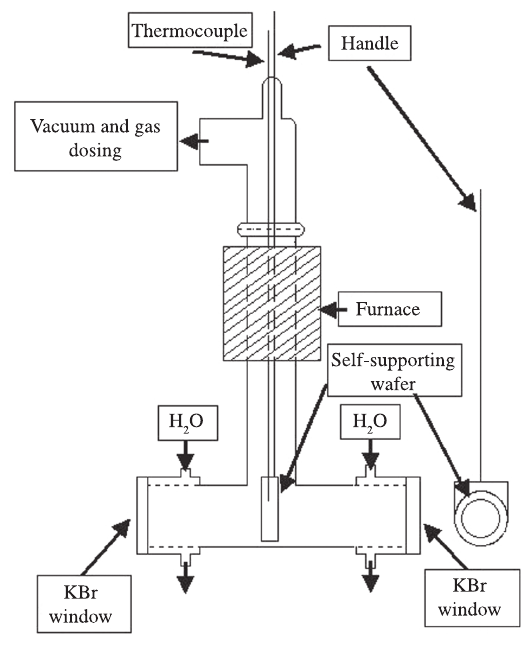
Figure 2. Schematic of high temperature vacuum cell.